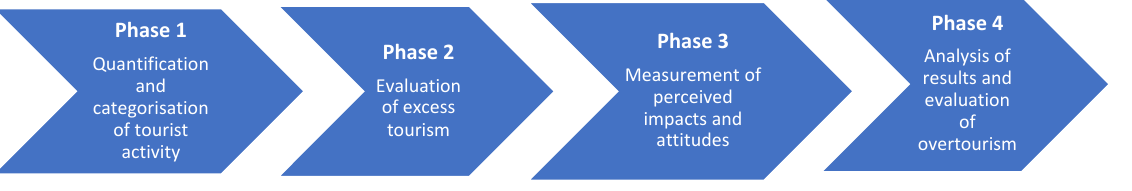
Figure 4. Phases of overtourism measurement.